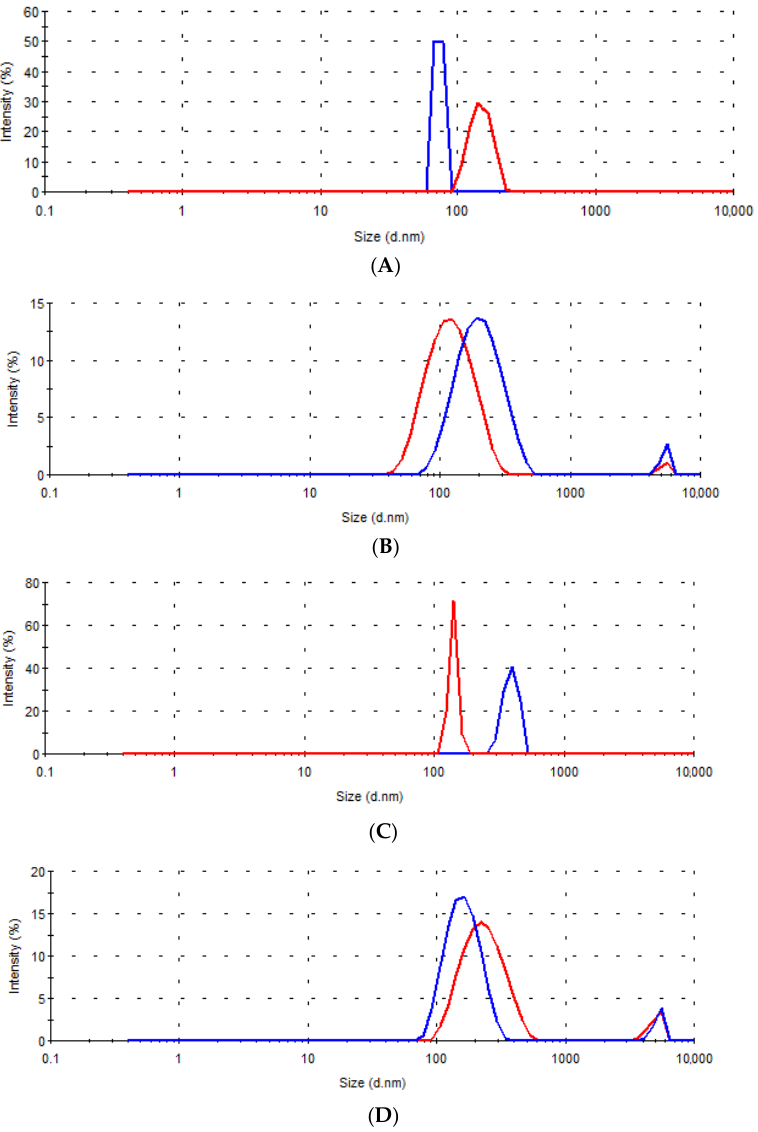
Table 8. The diameter and intensity of the peaks in size distribution curves obtained for the samples